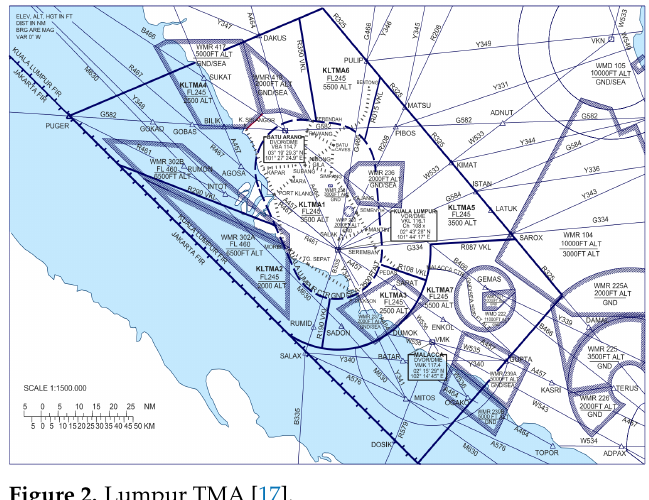
Figure 2. Lumpur TMA [17].